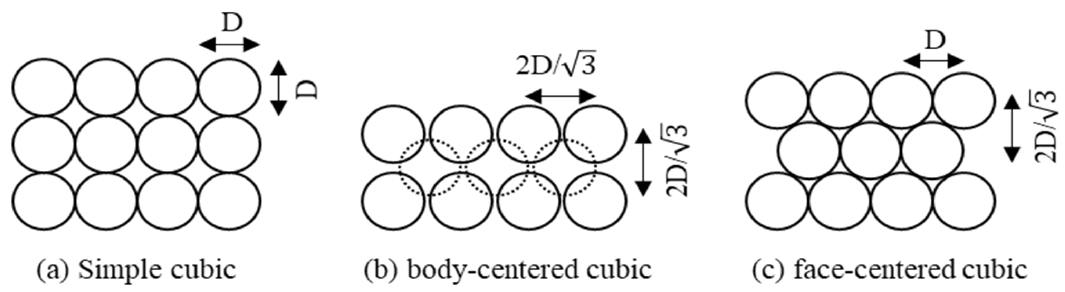
Figure 2. Cubic arrangement of a hollow glass microsphere for insulation [16].